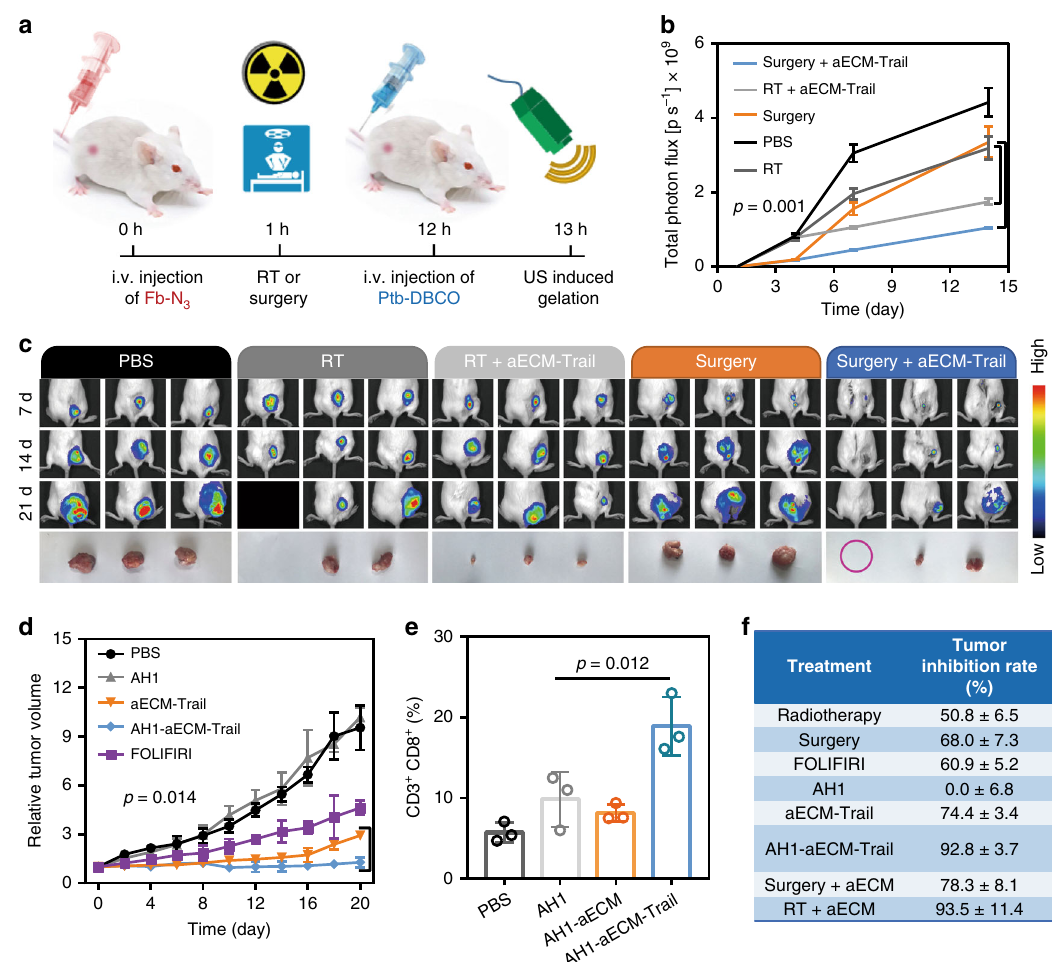
Fig. 7 Synergy of aECM with clinical operations. a Schematic diagram for the mechanism of surgery and RT (5 Gy) induced aECM gelation. b The anti- cancer effect of RT, aECM + RT, surgery and surgery + aECM towards subcutaneous CT26 luc tumor-bearing mice. Bioluminescence intensity of CT26 luc tumors was recorded every week. Three biological replicates are shown. c In vivo bioluminescence imaging of subcutaneous CT26 luc tumor-bearing mice after treatment with aECM gelation and clinical therapies. Mice tumors were collected after a 3-week treatment. Three representative images of fi ve biological replicates are shown. Black boxes denote dying mice. The purple circle represents the invisible tumor. d Synergy of aECM with immunotherapy in subcutaneous CT26 luc tumor-bearing mice Five biological replicates are shown. AH1-aECM, aECM and AH1 peptide (10 mg kg − 1 ) and FOLFIRI chemotherapy (30 mg kg − 1 5-FU, 90 mg kg − 1 leucovorin, 16 mg kg − 1 IRT, i.v.) were given. e Quanti fi cation of fl ow cytometric analysis of CD8 + CD4 − cells gating on CD3 + cells. The percentage of CD3 + CD8 + cells in CD3 + lymphocytes was analyzed. Three biological replicates are shown. f Comparison of tumor inhibition rates among FOLFIRI chemotherapy, radiotherapy, AH1 immunotherapy (10 mg kg − 1 ) and aECM treatment. Signi fi cance between every two groups ( b , d , e ) was calculated by using one-way ANOVA with Tukey post hoc analysis. The mean values and SD are